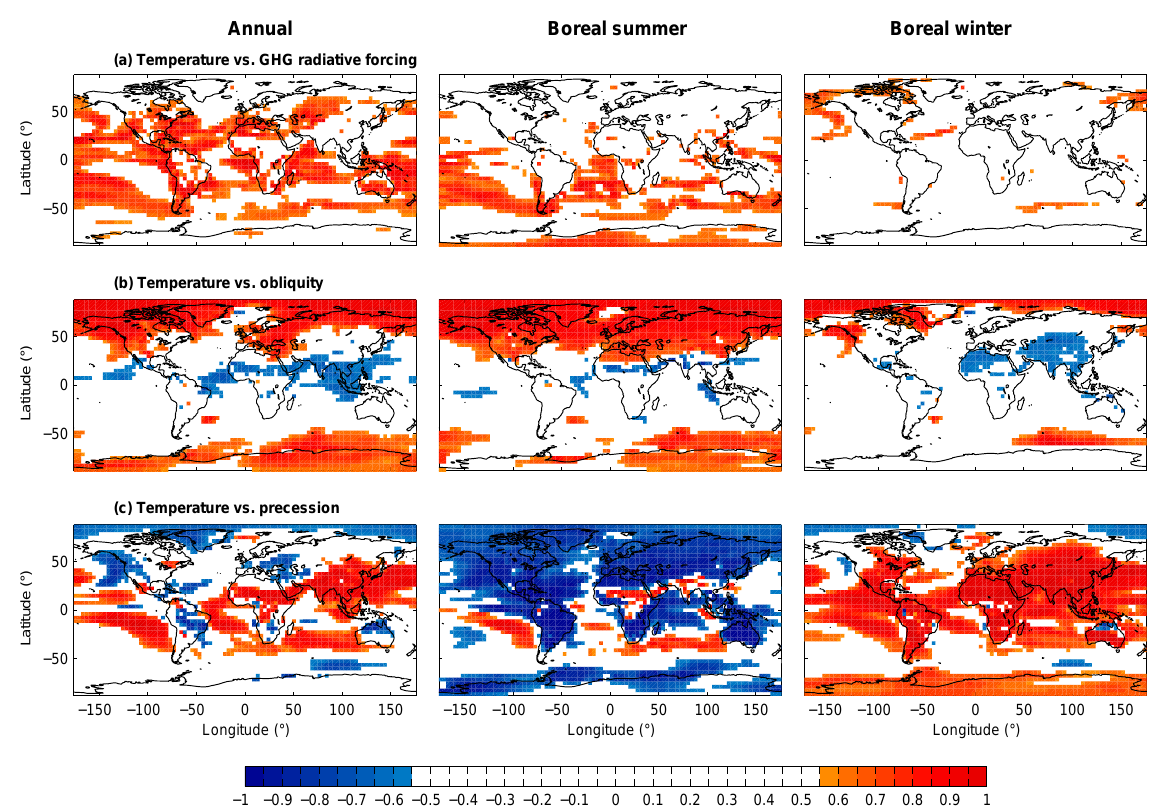
Figure 9. Linear correlation maps between surface temperature and GHG radiative forcing (a) , obliquity (b) , and climatic precession (c) as calculated from the entire set of experiments. Summer refers to JJAS, winter to DJF. Only significant values are shown, according to a two-sided Student’s t test at 95% confidence